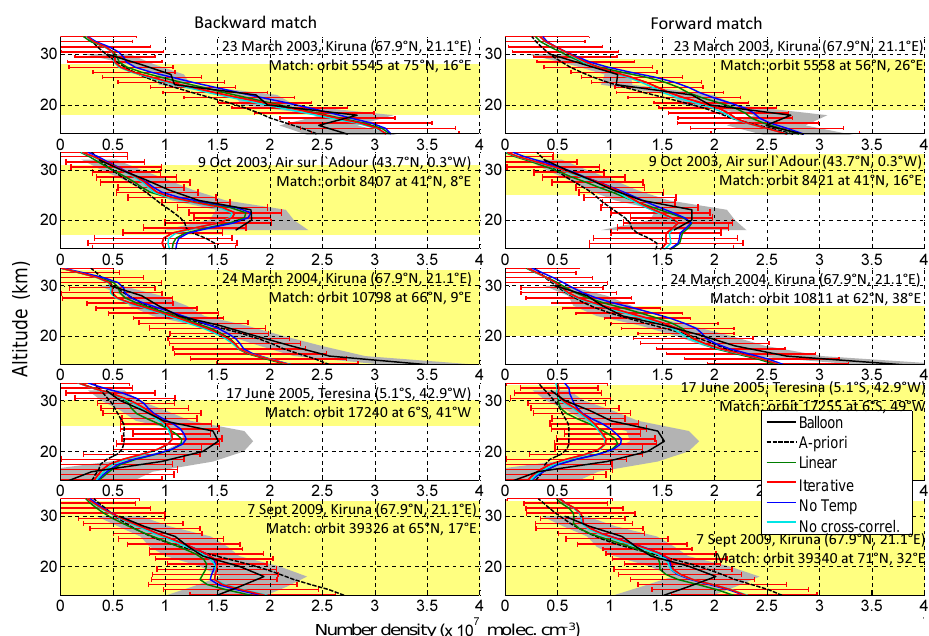
Figure 20. Comparison of SCIAMACHY BrO profiles retrieved by the linear approach (green), iterative approach (red), iterative approach without considering the temperature dependence of the cross sections (blue), and iterative approach without considering the cross-correlative terms in the calculation of the correction spectra (cyan) with collocated balloon observations. In order to match the SZA of the SCIAMACHY measurement the balloon results are photochemically corrected (Dorf et al., 2006, 2008). Grey areas illustrate the uncertainty of the balloon results (1 σ ). The altitude range where the sounded air masses of both instruments match is indicated by a yellow shading.